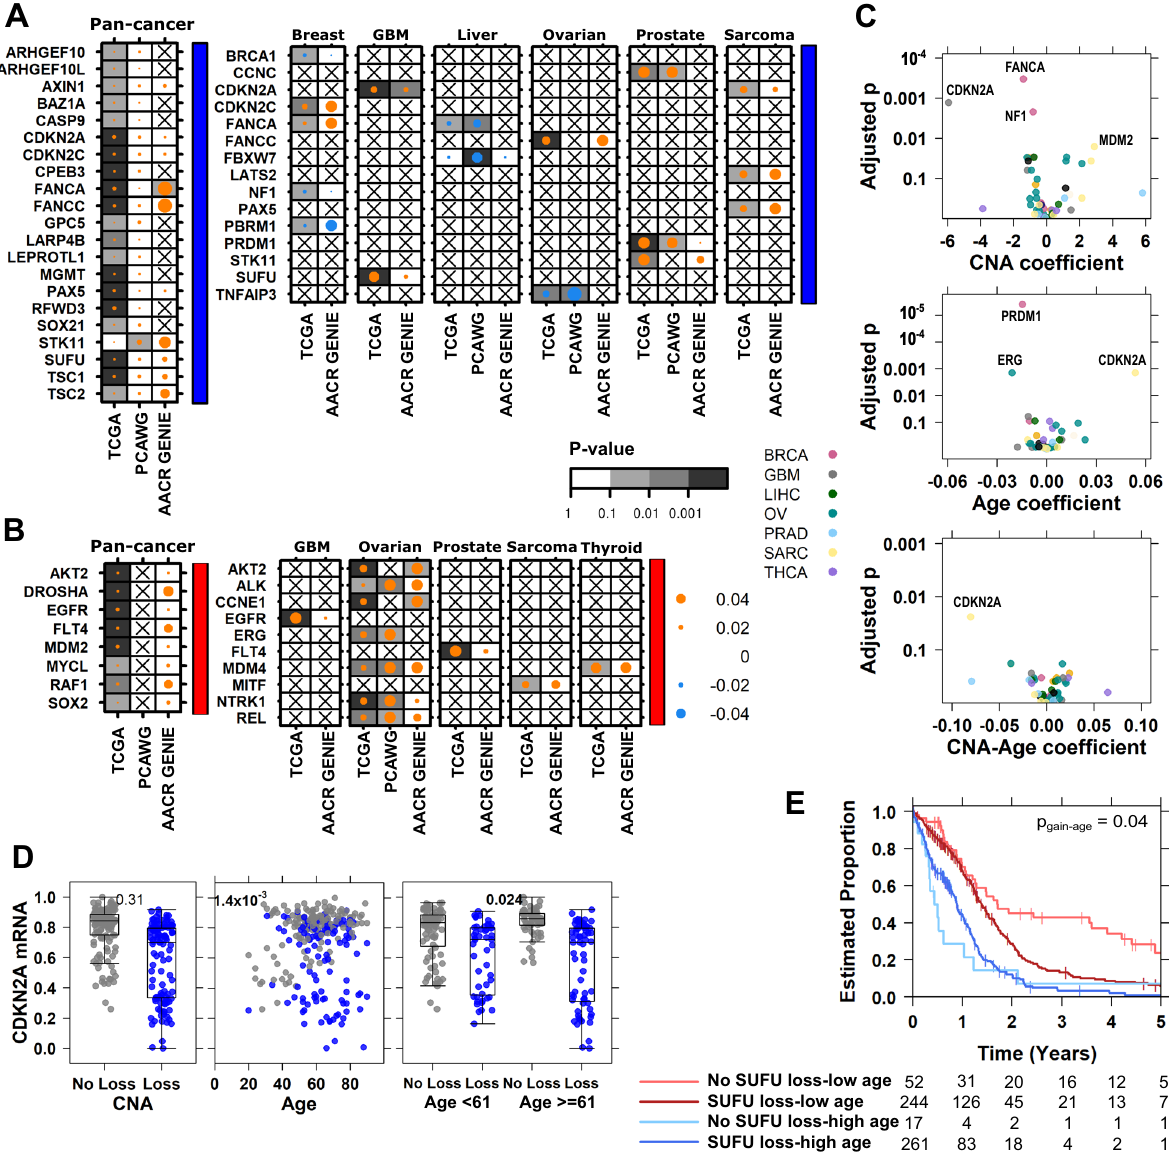
Fig. 3 Age-associations in copy number drivers are associated with functional changes in mRNA and survival. Summary of all detected age-associated CNAs for driver ( A ) losses (indicated by blue covariate bar) and ( B ) gains (red covariate bar) across three datasets. Dot size shows the magnitude of the association as the difference in proportion and the background shading shows adjusted multivariate p values. Right covariate indicates copy number gain drivers in red and loss drivers in blue. C Age-associated CNAs lead to differential mRNA abundance with respect to the CNA itself (top), age (middle), as well as age-speci fi c effects of the CNA (bottom). D In TCGA sarcoma ( n = 255 biologically independent samples), CDKN2A mRNA abundance changes between copy number loss (blue) or no loss (black) and broken down by age for low vs. high age. Tukey boxplots are shown with the box indicating quartiles and the whiskers drawn at the lowest and highest points within 1.5 interquartile range of the lower and upper quartiles, respectively. FDR-adjusted p values from two-sided Wilcoxon rank sum test and Spearman correlations shown. E SUFU loss in glioblastoma (GBM; n = 574 biologically independent samples) interacts with age to further stratify patient prognosis. The adjusted p value for the copy number loss-age interaction term is shown. Source data are provided as a Source Data fi